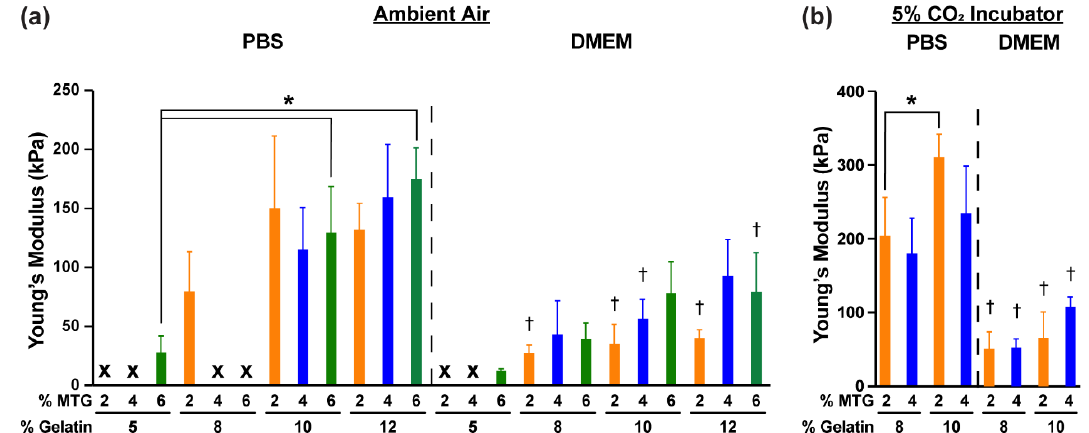
Figure 2. Elastic modulus values of gelatin-MTG hydrogels on Day 14 in ( a ) ambient air and ( b ) 5% CO 2 . Bars indicate standard deviation, n = 3–4. * indicates p < 0.05 for each incubation condition, based on two-way ANOVA and Tukey’s multiple comparison test. † indicates p < 0.05 compared to the same gelatin-MTG formulation in the same incubation environment (ambient air or 5% CO 2 ) but incubated in PBS, based on student’s t -test. For some conditions, datapoints are excluded (indicated by X) because the samples degraded prior to the measurement.